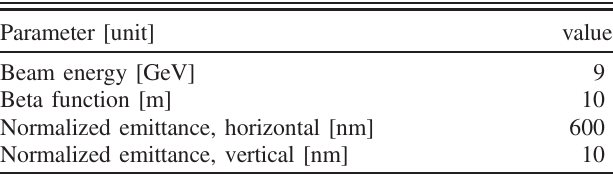
TABLE I. CLIC beam parameters at the beginning of the main linac [1].